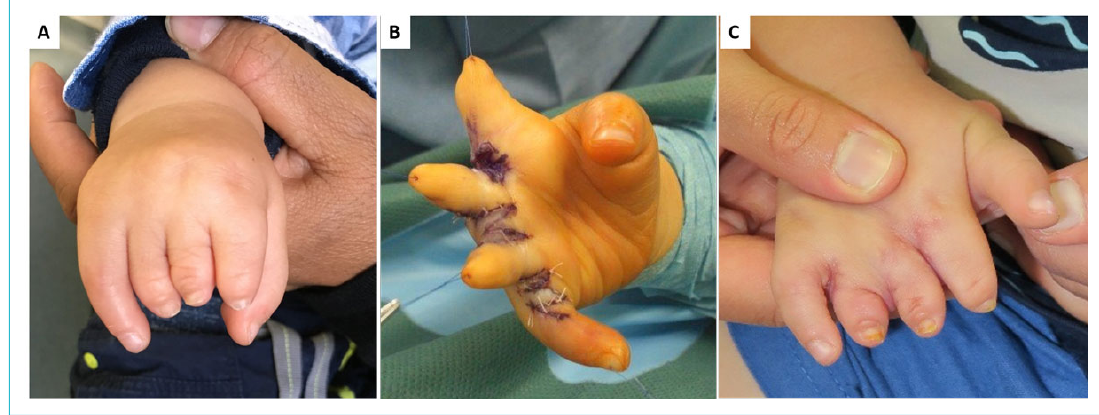
Figure 3: Defective finger joint development due to symbrachydactyly. (A) Macroscopic view of the right hand in a 2-year old boy. On palpa- tion only the proximal phalanx was present in an intact soft tissue envelop. (B) Intraoperative result by web deepening, with double opposing Z-plasties (jumping man) flaps in the third and fourth web and a syndactyly release with a graftless technique (Seagull flap) in the second web. (C) Postoperative assessment indicates minimal scarring but limited functional and aesthetical gain. Stabilisation of the digits for improvement of grasp without donor site issues remains challenging, but could be facilitated by the use of engineered bone